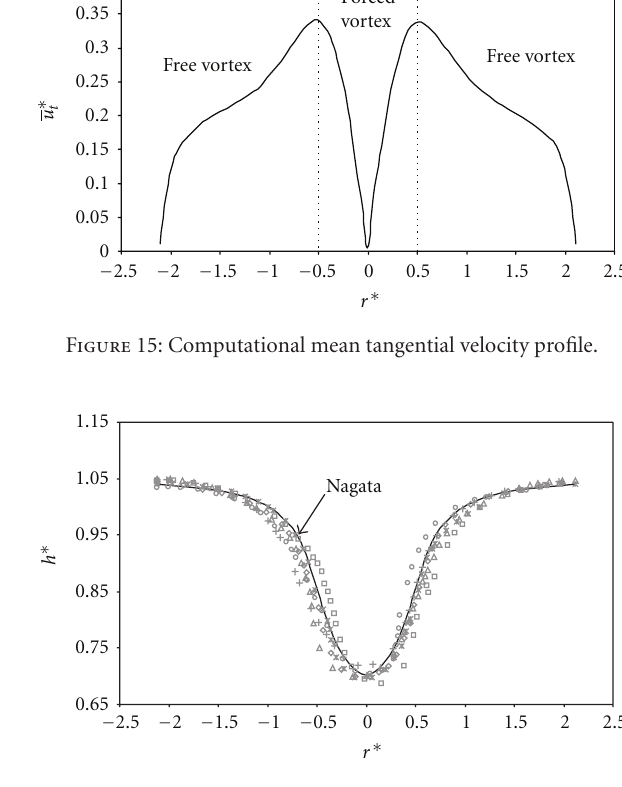
Figure 16: Comparison between computational vortex profiles (points) and Nagata’s theory (black